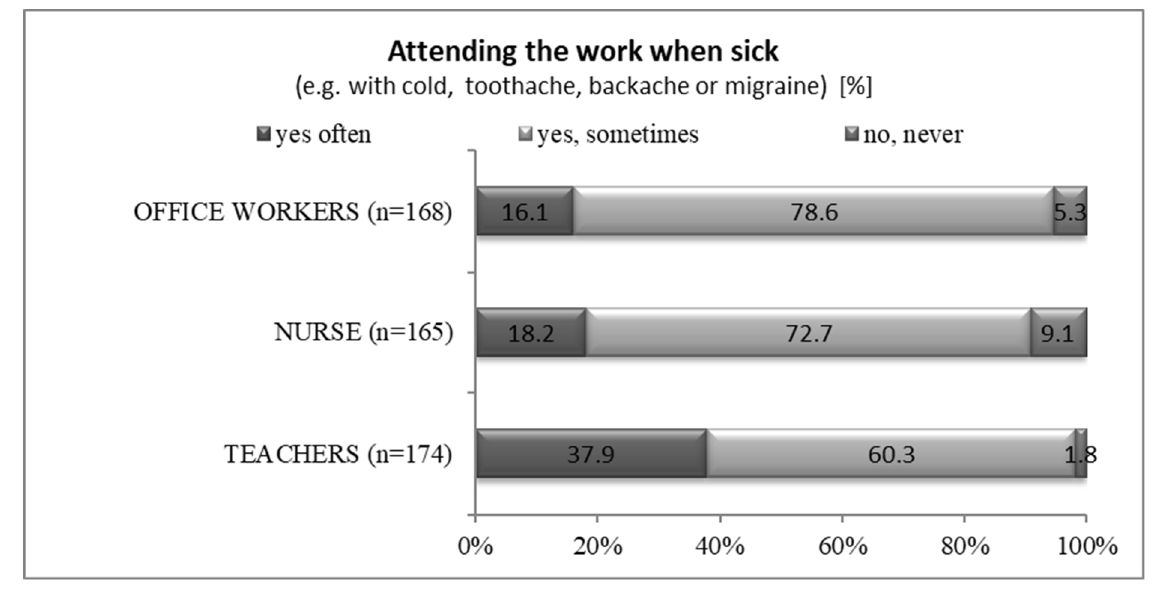
Figure 1. Sickness presence among the respondents. Table 2. Sickness presence and characteristics of the respondents (%) with p -values for the chi- squared test.